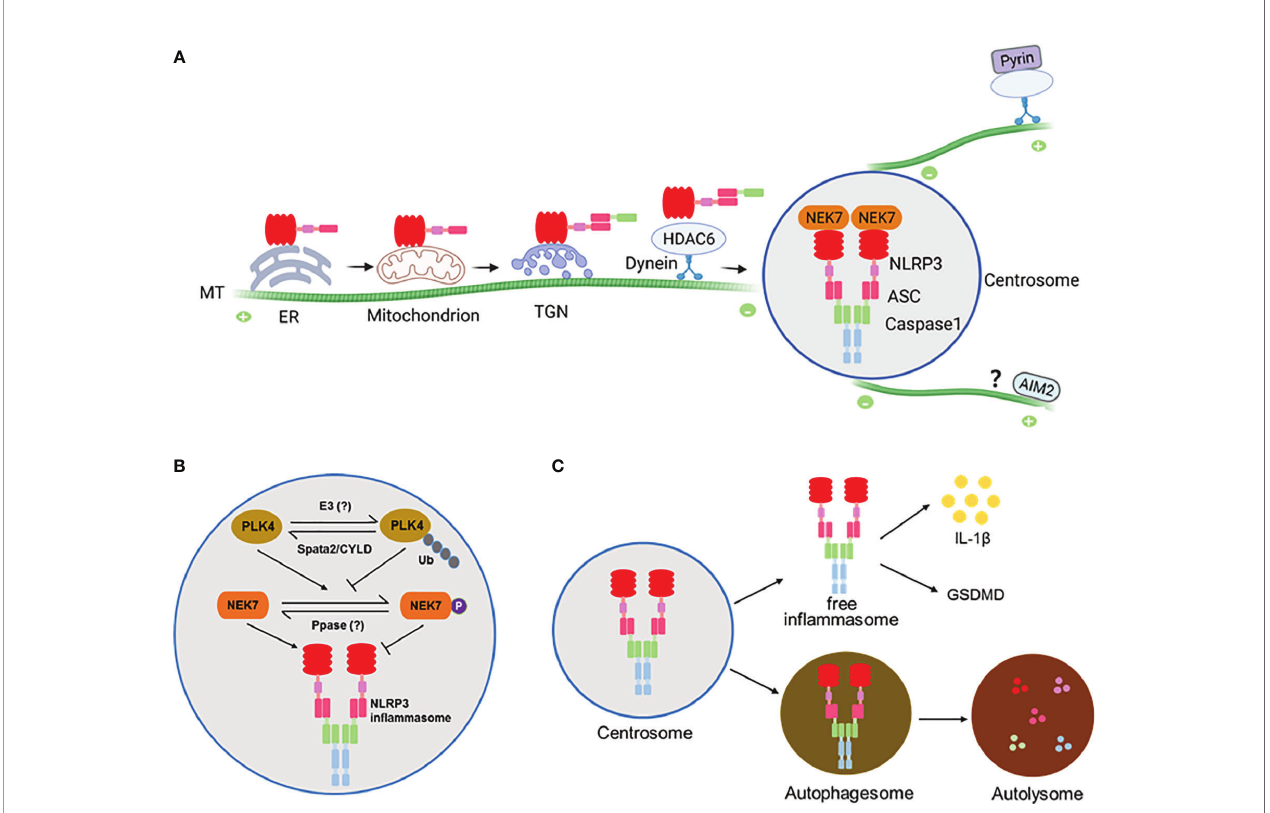
FIGURE 1 | (A) A model for assembly and activation of in fl ammasomes at the centrosome. NLRP3 protein is largely associated with the ER before stimulation and becomes associated with mitochondrion or trans-Golgi network (TGN) where it is engages ASC to form complex that is traf fi cked to the centrosome along the microtubules (MTs) by the HDAC6-Dynein motor machinery. At the centrosome NLRP3 and ASC interact with NEK7 and Caspase1 to fi nish assembly and activation. The Pyrin in fl ammasome is similarly assembled and activated at the centrosome. It ’ s likely that the AIM2 in fl ammasome might also be activated at the centrosome via an unknown mechanism. (B) Regulation of NLRP3 in fl ammasome at the centrosome by the centrosomal deubiquitinase complex Spata2-CYLD. Spata2-CYLD mediates the deubiquitination of PLK4 to promote PLK4 phosphorylation of NEK7, which inhibits NEK7-NLRP3 interaction and thereby NLRP3 in fl ammasome activation. (C) NLRP3 in fl ammasome assembled at the centrosome can exit into autophagosomes that fuse with lysosomes to cause in fl ammasome